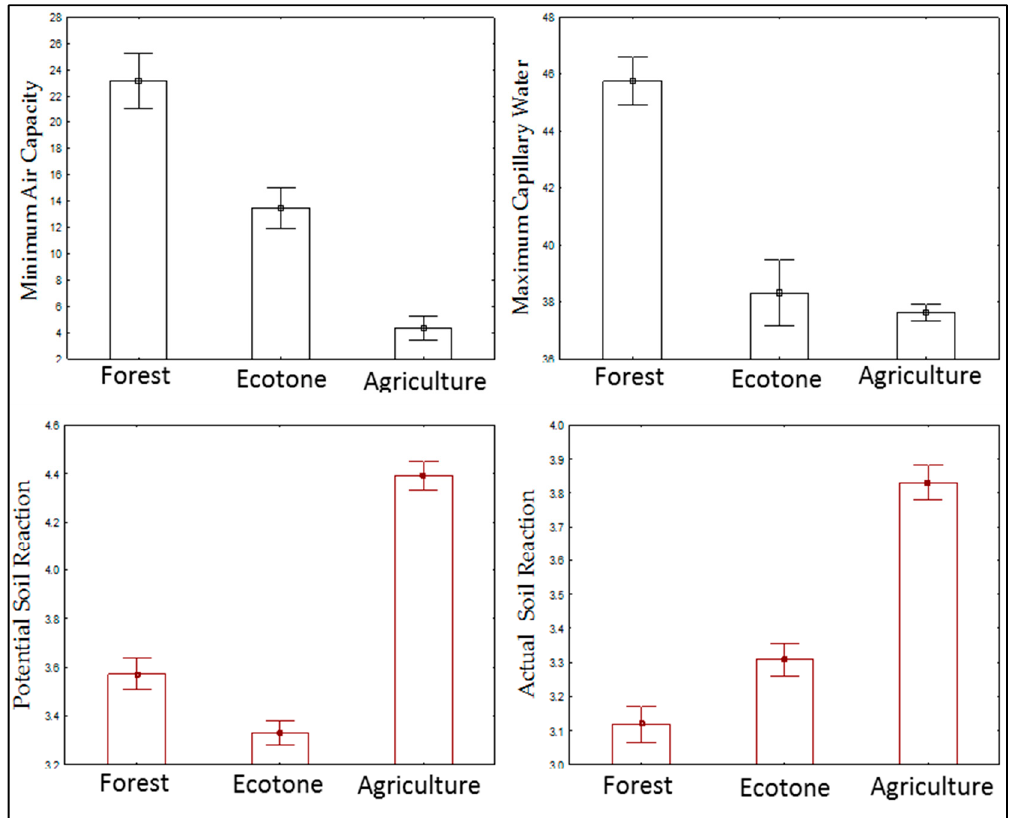
Figure 3. Comparative illustration of the seven-month trend obtained from the forest ecotone and agriculture site.